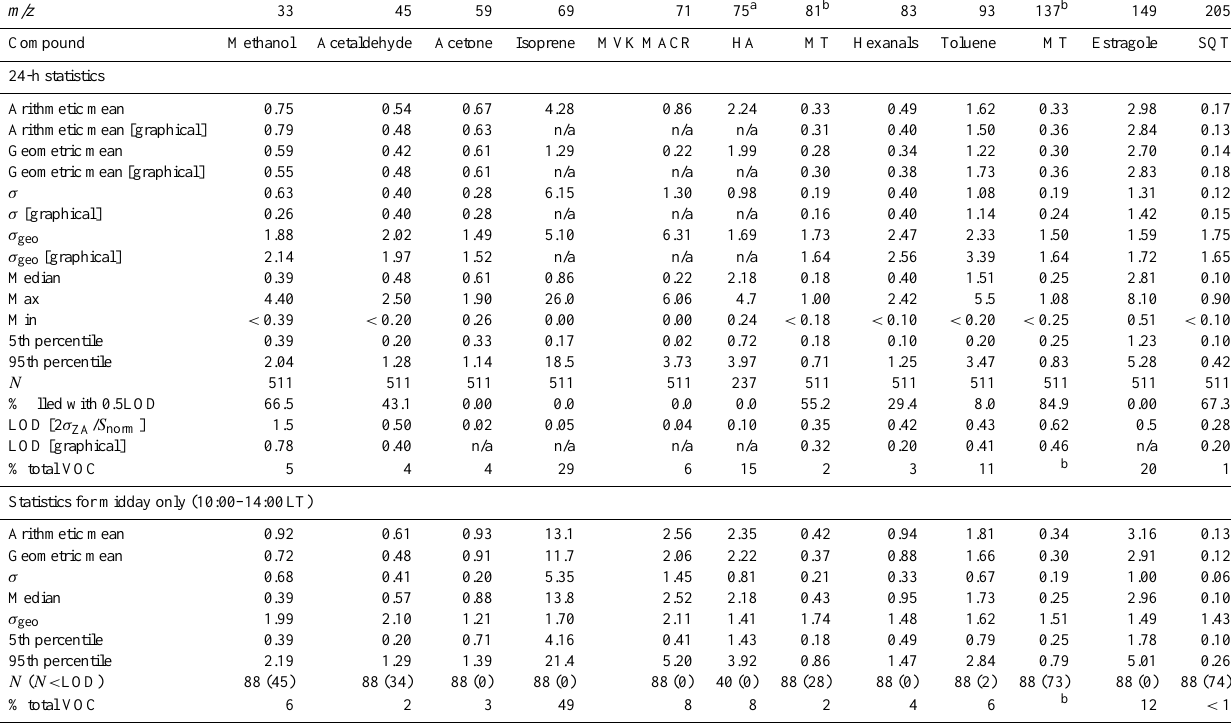
Table 1. Statistical summary (11 days) of volume mixing ratios (ppbv) of 11 targeted